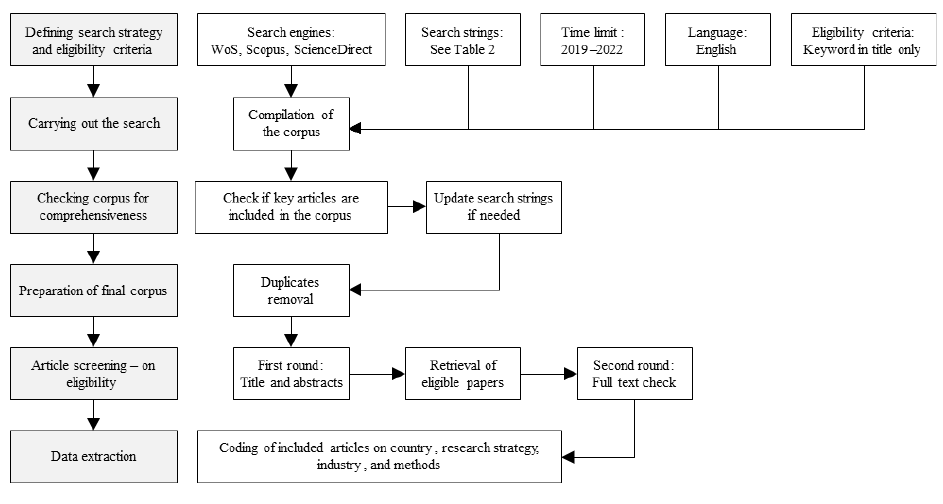
Figure 1. Overall research process scheme .